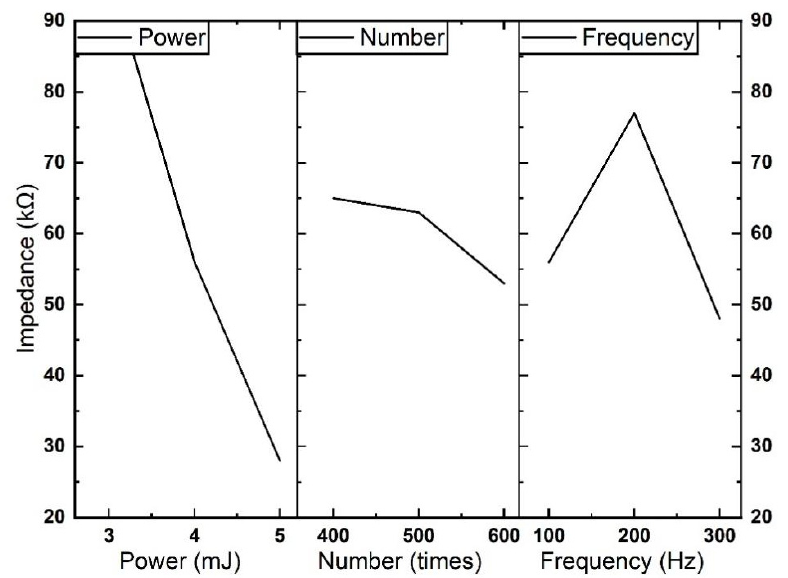
Figure 3. Effect curve of electrochemical impedance using 200 μ m circle template at 1 kHz.